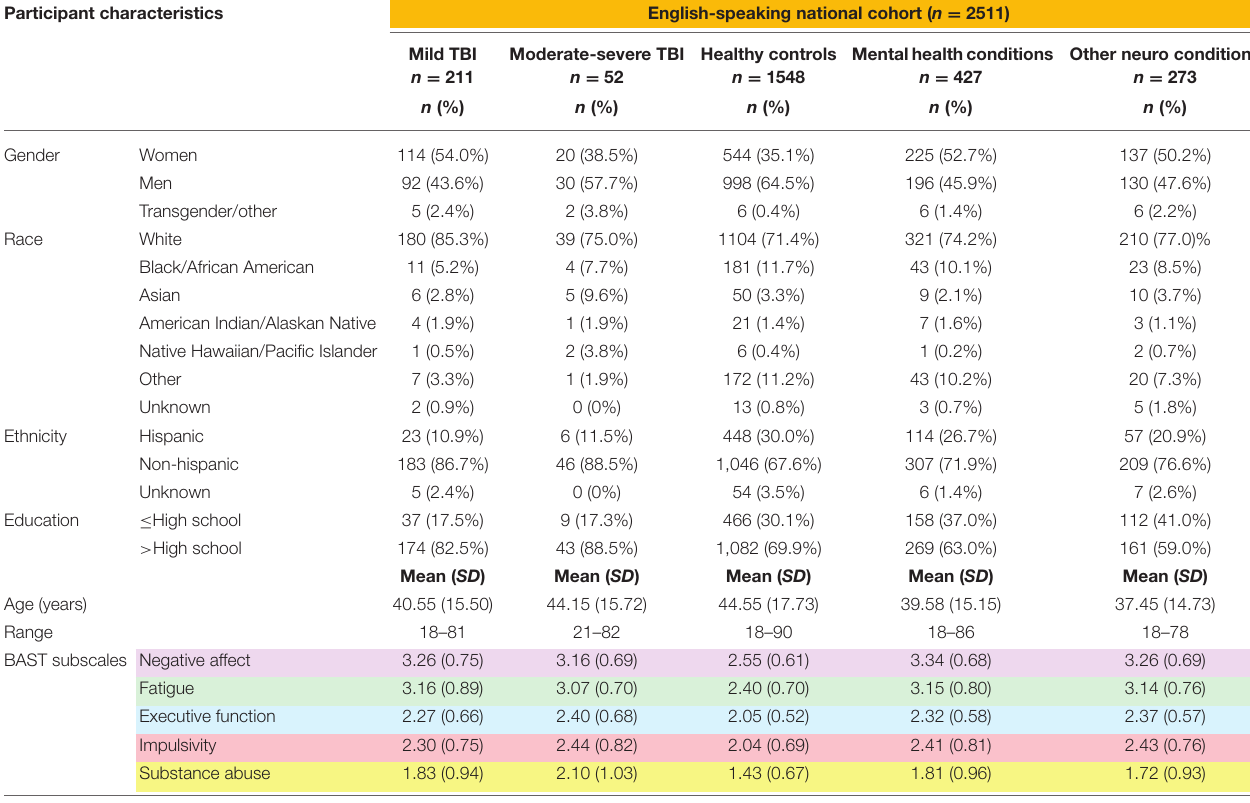
TABLE 1 | Demographics and neurobehavioral symptoms in English-speaking community-dwelling adults with and without TBI. Participant